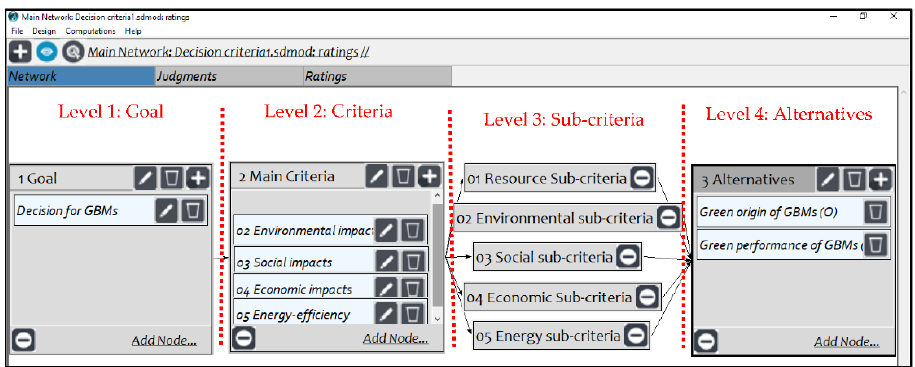
Figure 4. A snapshot of the hierarchical model in Super Decisions software.